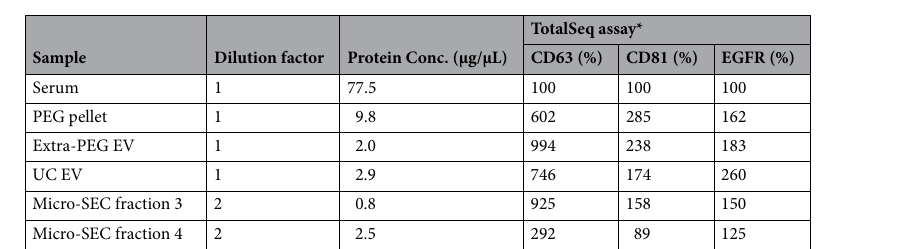
Table 3. Comparison of micro-SEC with other EV enrichment method. *Normalized to serum sample.